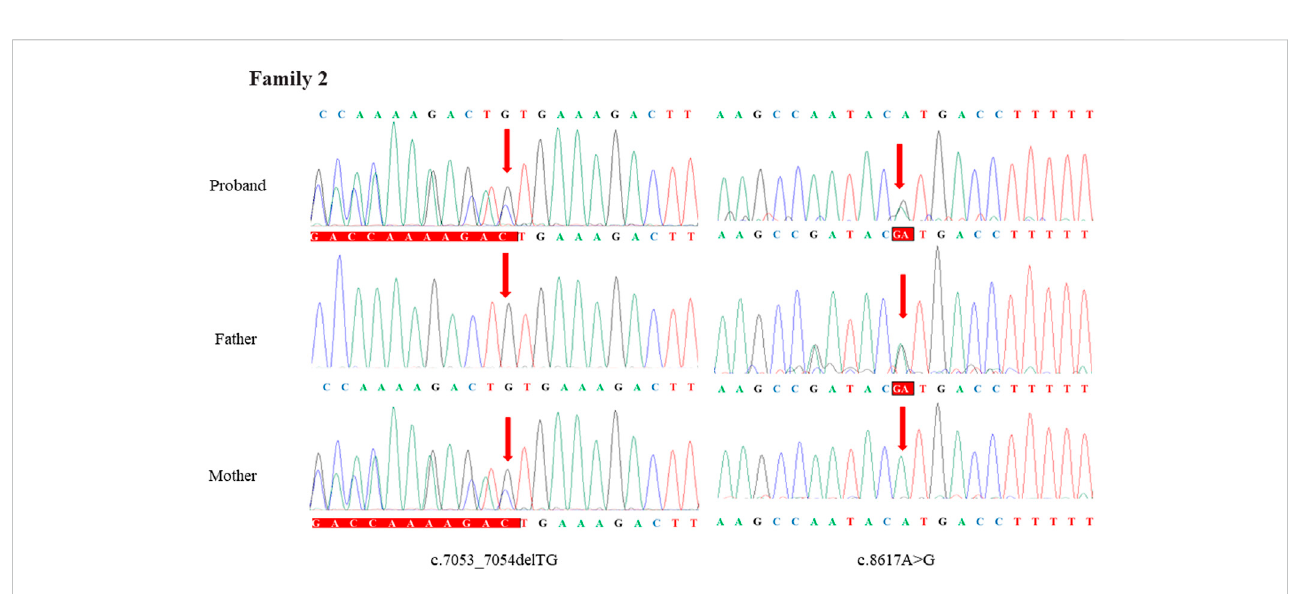
FIGURE 6 Sanger sequence analysis of the mutations of DYNC2H1 gene in the family